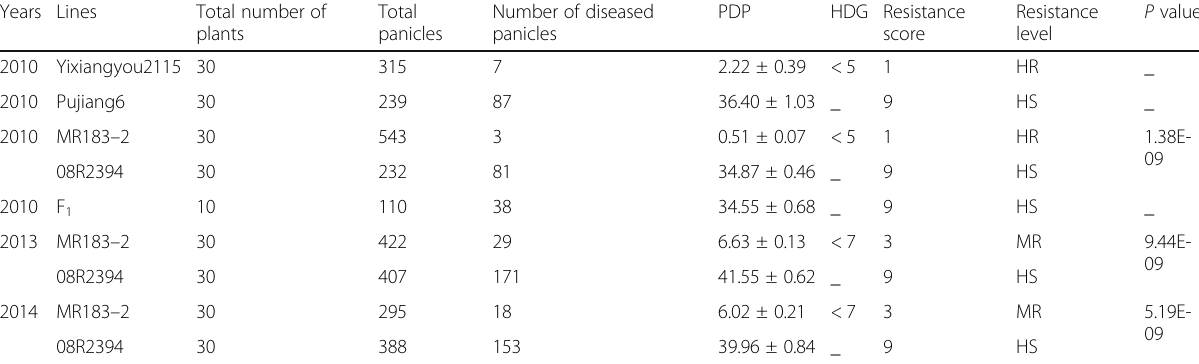
2). The results indicate that false smut resistance in PDP was 89.47%, indicating a wide range of variation MR183 – 2 is under polygenic control and that the RIL- (Table 2). The false smut resistance scores of RIL-F 7 F lines were categorized based on the PDP and HDG population is suitable for genetic analysis. The head- 7 (Fig. 2 and Additional file 1: Table S1). The absolute ing dates (HD) of parental cultivars and RILs were also value of the skewness and kurtosis of resistance scores recorded. A significant and positive correlation was de- was less than 1, indicating an approximately normal dis- tected between false smut resistance scores and heading tribution of resistance levels of RIL population (Table 2 dates (r = 0.47, P < 0.001) (Fig. 2). The results suggest and Fig. 2). Interestingly, the transgressive phenotype in that false smut resistance is negatively correlated with false smut resistance was observed in some F the growth period length of rice. lines (Fig. 7 Table 1 False smut disease phenotypes of MR183 – 2 and 08R2394 after natural infection in a disease nursery in Ya ’ an, Sichuan Province, China in different years Years Lines Total number of Total plants